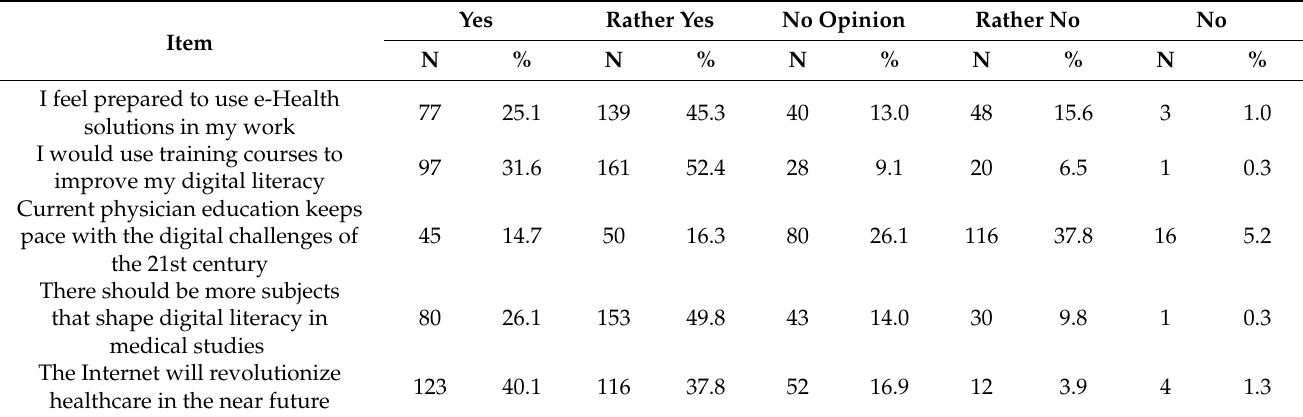
Table 2. Physicians’ digital literacy and the aspects of this